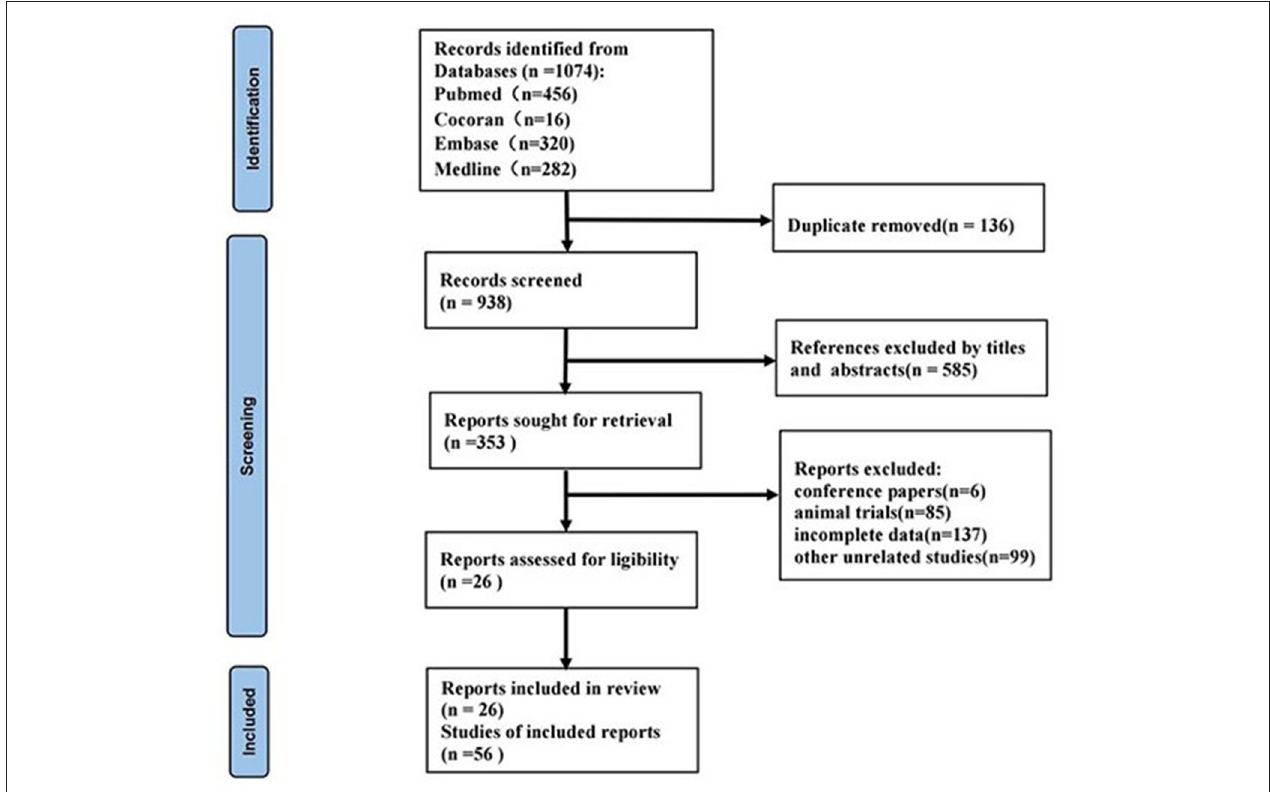
FIGURE 1 | Flow diagram of the study